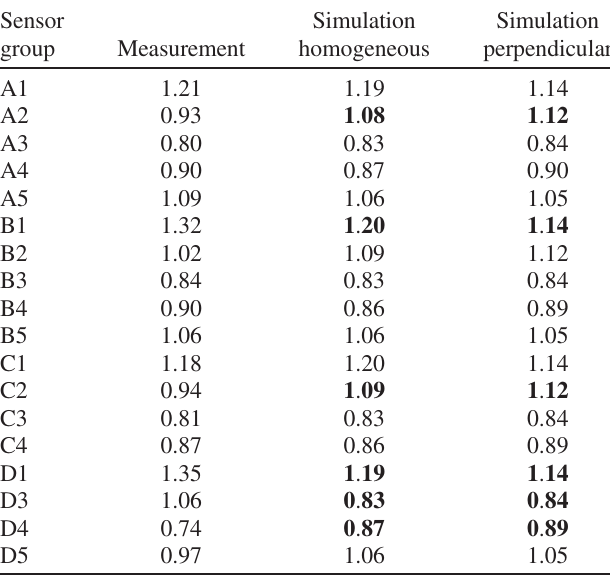
with homogeneous trapping, and simulation with perpendicular trapping normalized to the mean magnitude for each data set, respectively. The external field is applied at α ¼ 90 °. If the simulation significantly ( 3 σ ¼ 12% ) differs from the measure- ments, the value is highlighted in bold. Due to broken sensors, sensor groups C5 and D2 are not